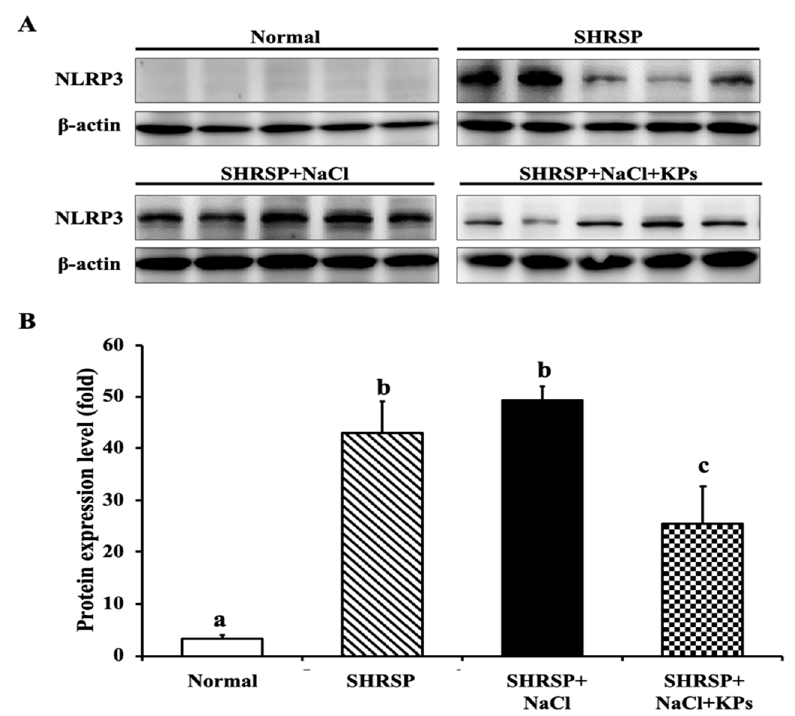
Figure 7. KPs reduced the NLRP3 inflammasome expression in the kidneys of salt-treated SHRSP rats, as determined by Western blot analysis. ( A ) NLRP3 inflammasome protein expression was elevated in 60% ( 3 / 5 ) of the untreated SHRSP rats and 100% ( 5 / 5 ) of the salt-treated SHRSP rats, but only a small amount of NLRP3 inflammasome was present in the SHRSP rats administered KPs. ( B ) Quantitative analysis of the results of the Western blot analysis to determine the NLRP3 protein expression level by ImageQuant TM TL8.1 analysis software. Data are presented as the means ± SEMs (Normal, n = 5; SHRSP, n = 5; SHRSP + NaCl, n = 6; SHRSP + NaCl + KPs, n = 6) and were analyzed by one-way ANOVA. Data within columns that are not labeled with the same letter are significantly di ff erent ( p < 0.05), as determined using Duncan’s test.